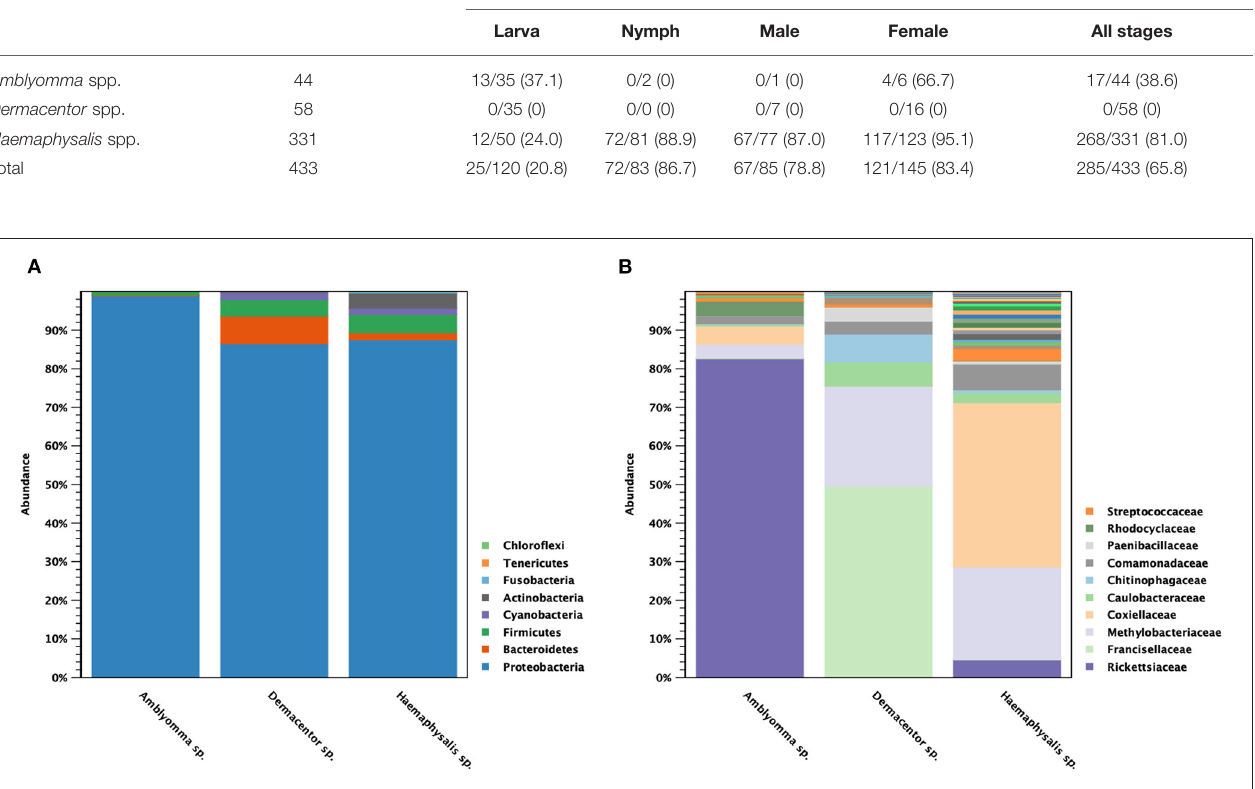
harboring the Coxiella -like endosymbiont [16.1%, CI (11.9, 20.4%)] and ticks without Coxiella -like endosymbiont [10.8%,